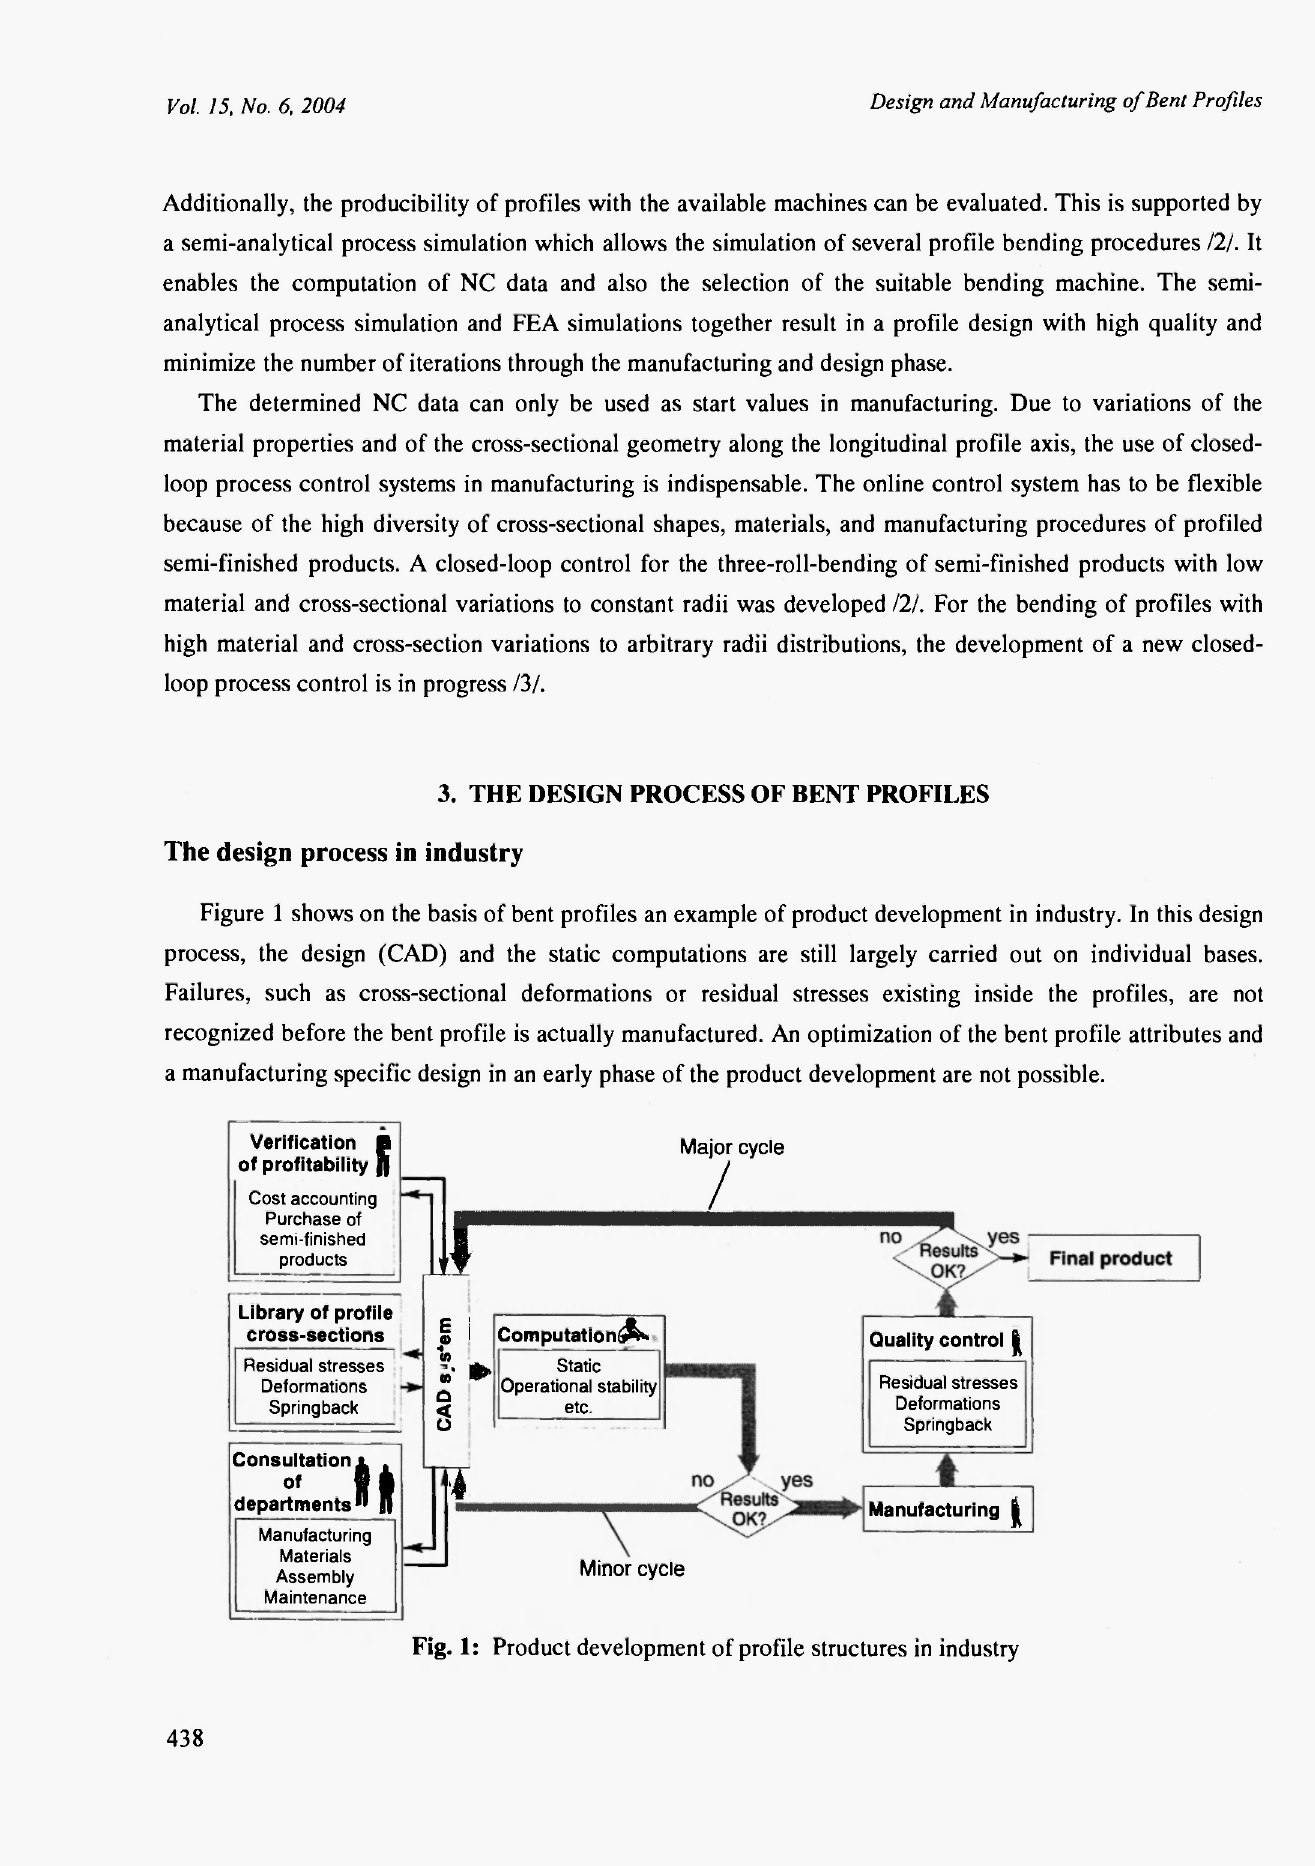
Fig. 1: Product development of profile structures in